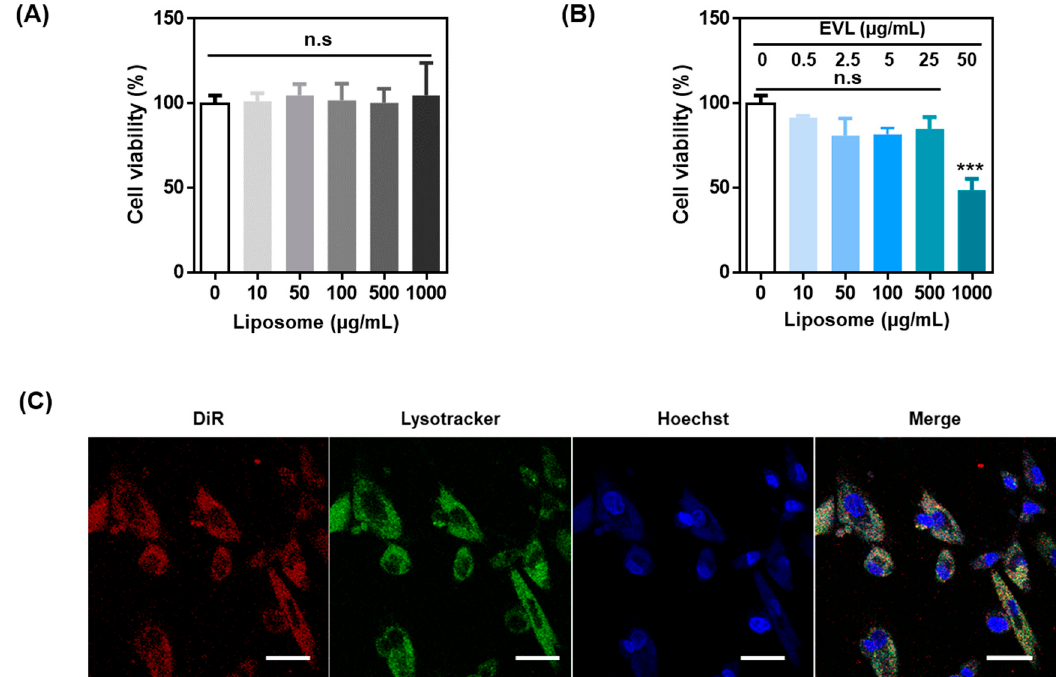
Figure 3. In vitro study using liposome and EVL-loaded liposome. Cell viability of ( A ) liposome and ( B ) EVL-loaded liposome. ( C ) Confocal images for interaction between DiR-labeled liposome and HCASMCs. The lysosome and nucleus of HCASMCs were stained by lysotracker (green) and Hoechst (blue), respectively (Scale bars equal to 40 μ m). Values are presented as mean ± SD ( n = 3) and statistical significance was obtained with one-way analysis of ANOVA with Tukey’s multiple comparison post-test (* p < 0.05; ** p < 0.01; *** p < 0.001). HCASMCs: Human Coronary Artery Smooth Muscle Cells.